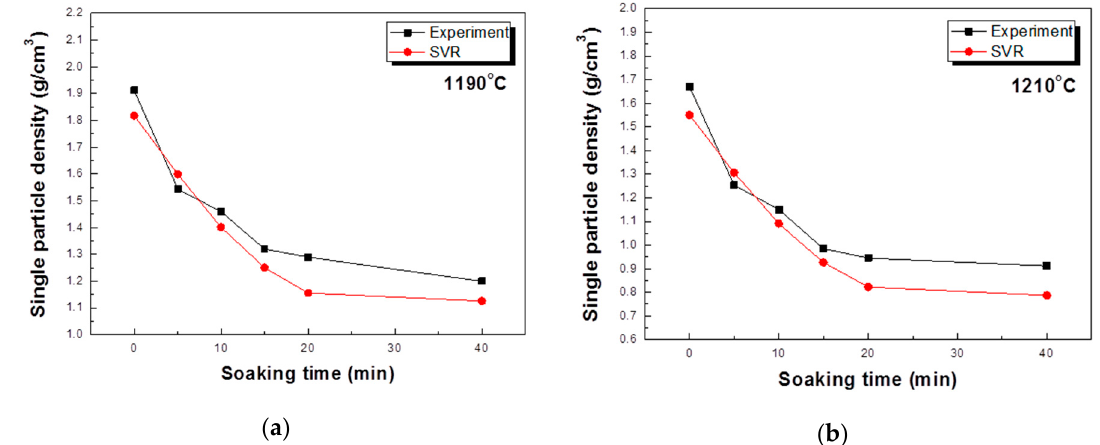
Figure 8. Prediction of the single particle density according to the SVR method: ( a ) 1190 °C , ( b ) 1210 °C .